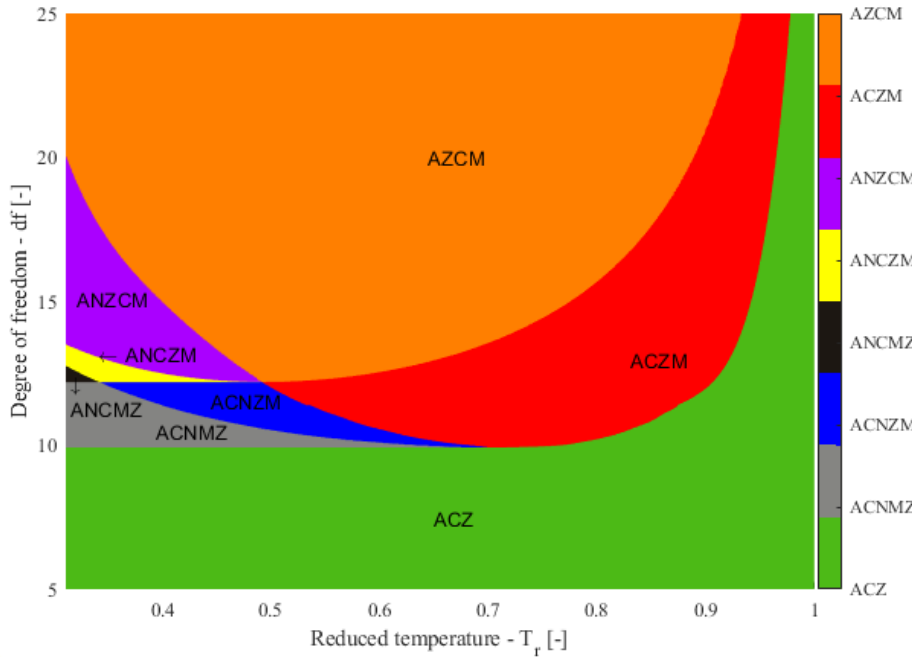
Figure 4. Reduced temperature vs. molecular degree of freedom for simple, one-component van der Waals fluids. Three-letter, four-letter, and five-letter parts show various wet, dry, and real isentropic